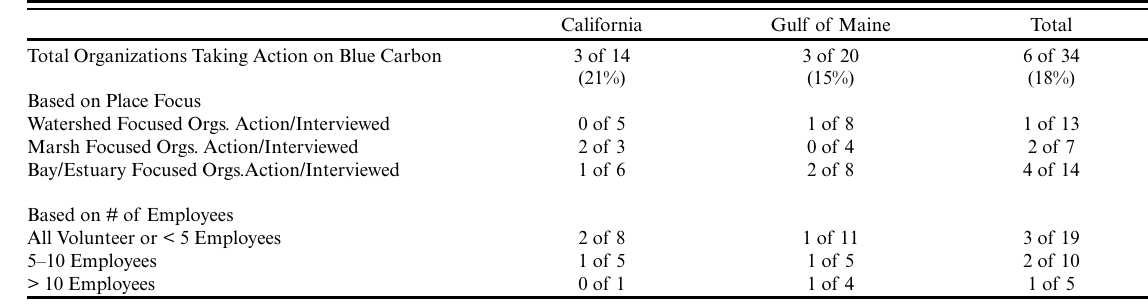
Table 2 . Organizations taking action on blue carbon.